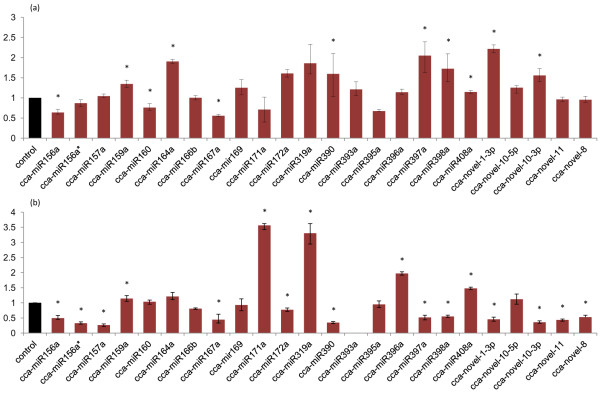
miRNA quantitative expression. Expression levels of selected artichoke miRNAs by means of qPCR in leaves (a) and roots (b) under control (black bar, arbitrarily set to 1) and NaCl stress (colored bars) conditions. Expression levels are given as fold change of stressed versus control tissues. Asterisks indicate significance at a p value of < 0.05. Bars refer to standard error.